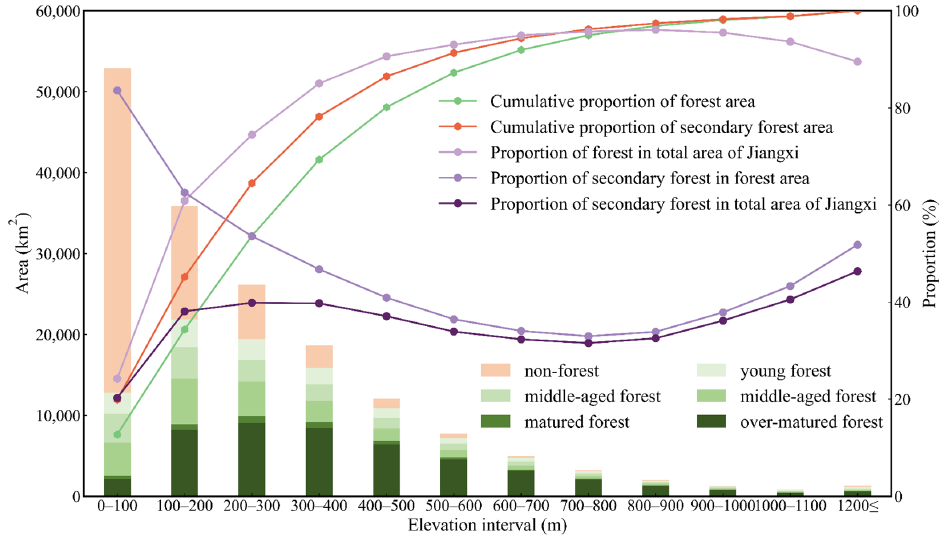
Figure 10. Topographical characteristics of secondary forest spatial pattern.